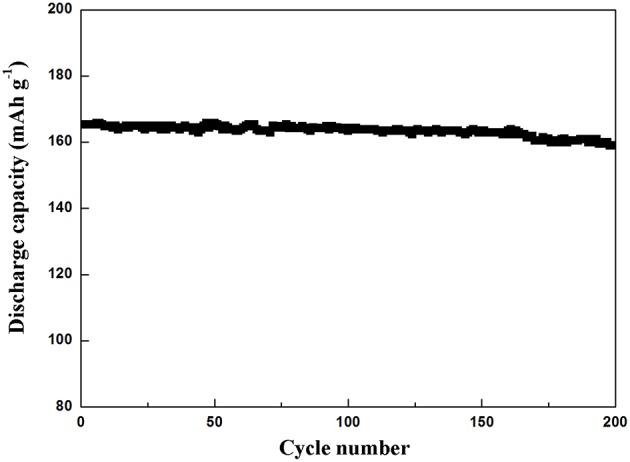
Cycle property of Li4Ti5O12@CN composite at 10 C.